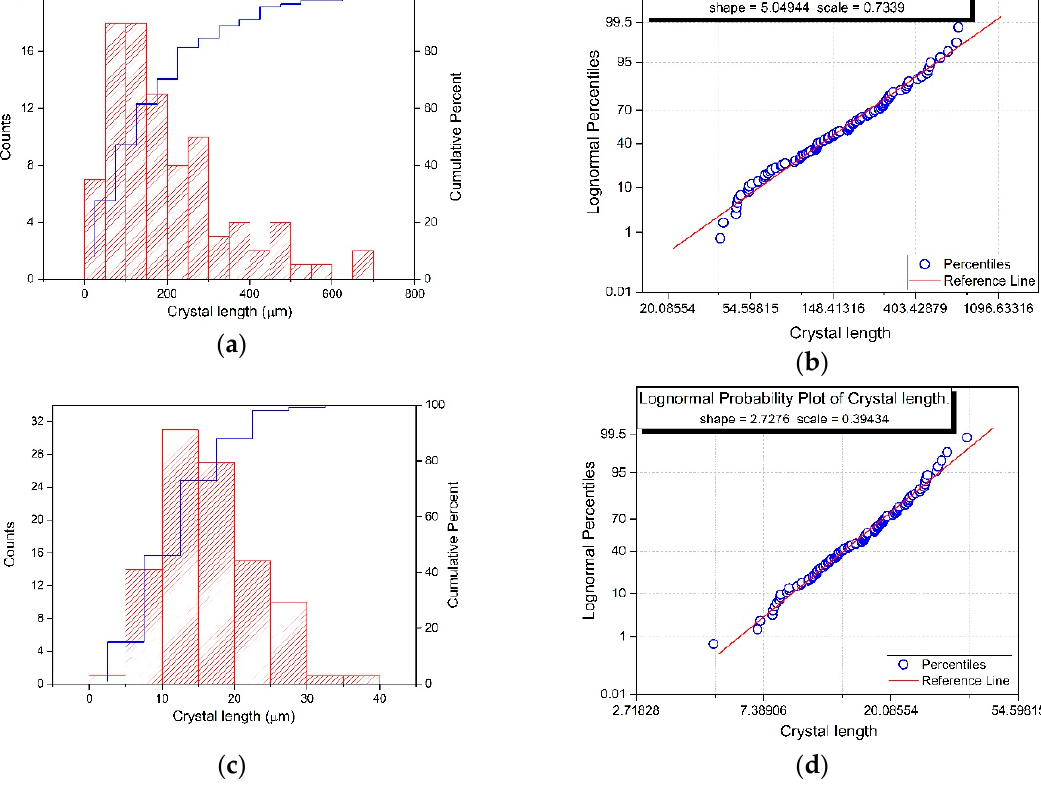
Figure 1. Optical microscope images of NPG crystals of ( a ) NPH HG and ( b ) NPG BM obtained at x5 and x20 magnification, respectively.